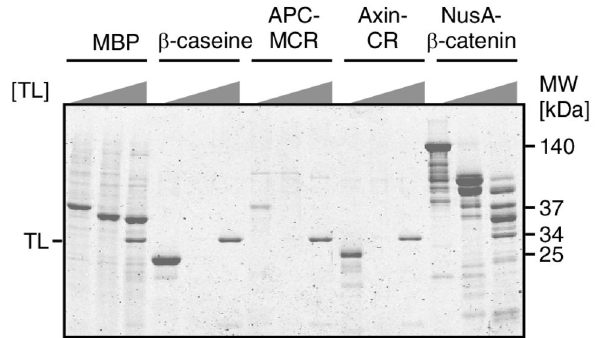
Figure 2. MCR is susceptible to TL digestion. Resistance of well-characterised folded and unfolded proteins is compared with MCR by using TL concentrations of 0 g/L, 0.001 g/L and